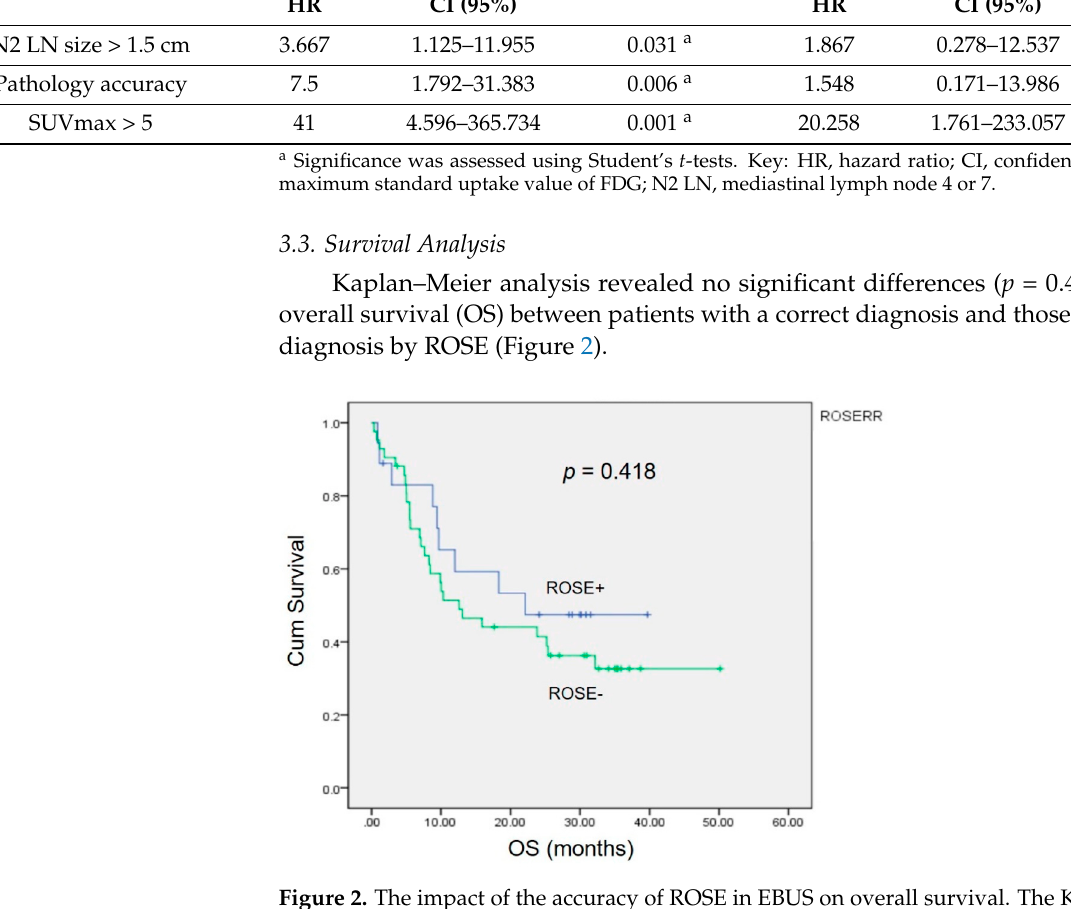
Figure 2. The impact of the accuracy of ROSE in EBUS on overall survival. The Kaplan–Meier curve showed no statistically significant difference ( p =